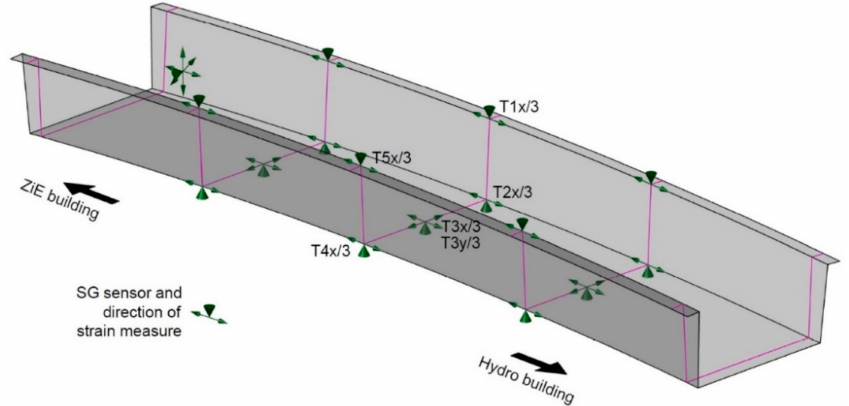
Figure 9. Location of SG